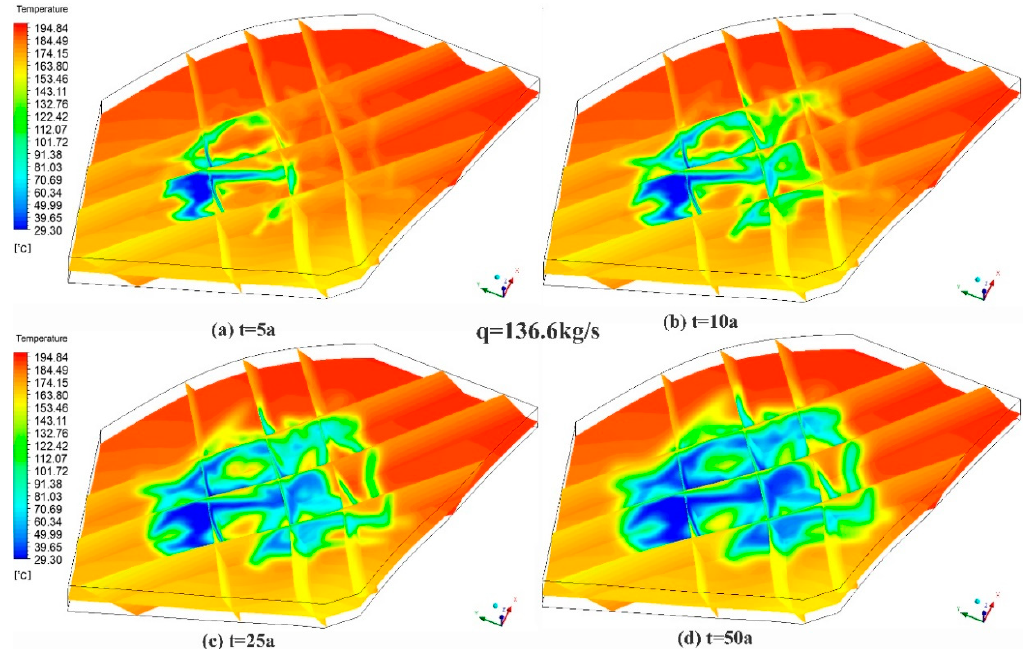
Figure 11. Temperature contour at injection rate of 136.6 kg/s.